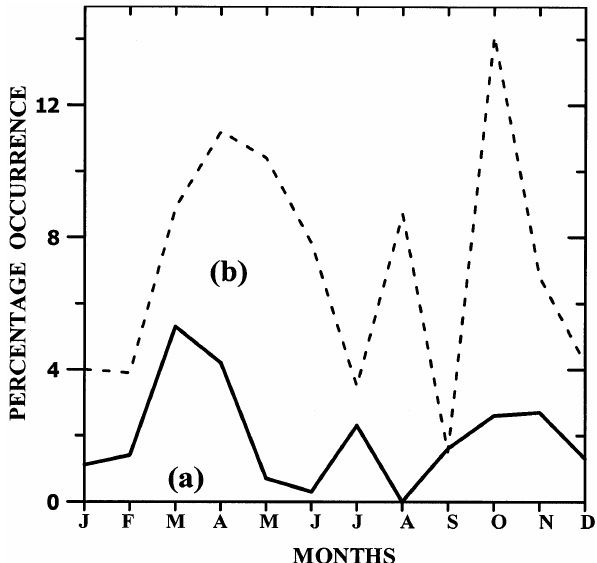
Fig. 4. Seasonal variations of proxies for gravity wave activity in the mesosphere (M-100 rocket data) – See text. (a) Percentage occurrence of temperature lapse rates > 6 K km − 1 in the meso- sphere (65–80 km) over Trivandrum (8.5 ◦ N, 77 ◦ E) for a period of 9 years (solid curve), (b) Same as (a) but for Richardson number < 1 (dashed